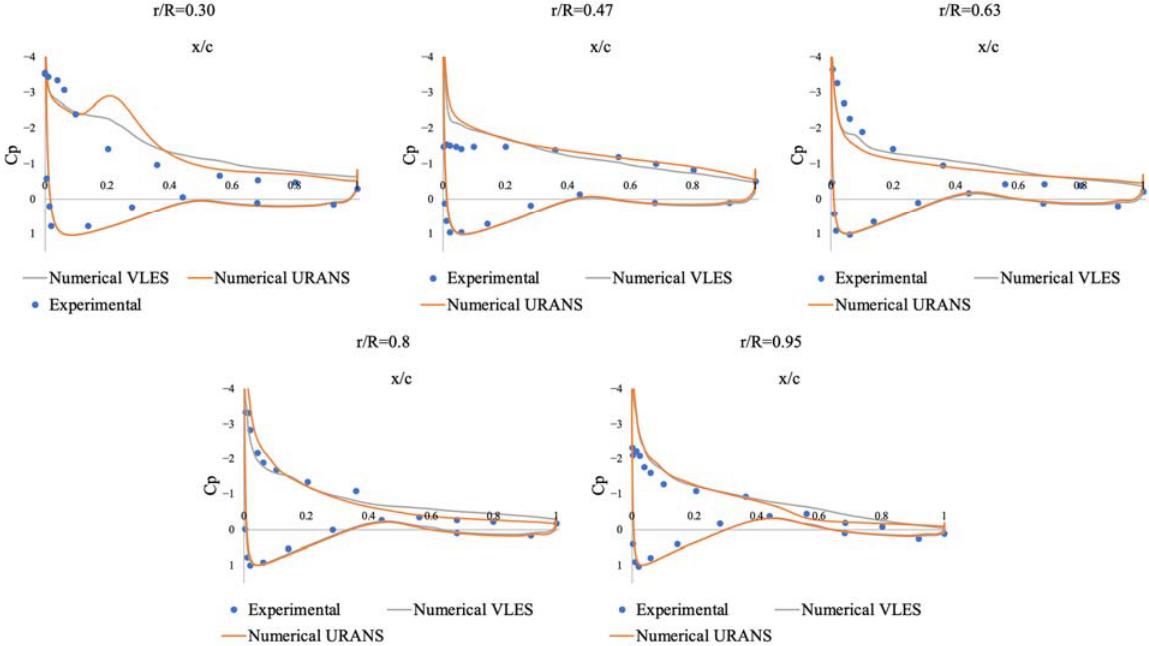
Figure 13. Pressure coefficients of URANS, VLES, and experiment (wind speed = 10 m/s).